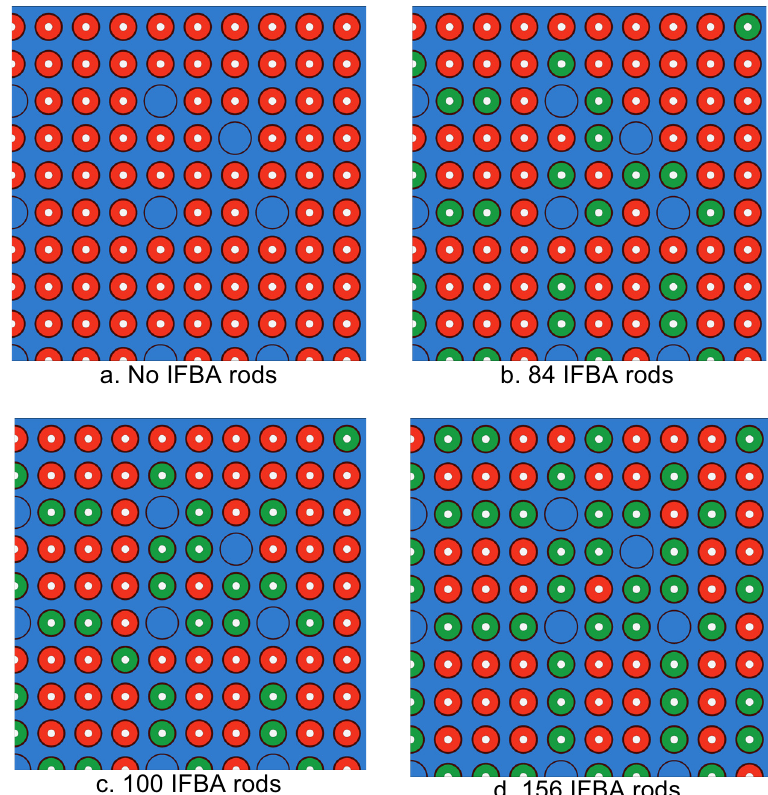
Fig. 3. I 2 S-LWR IFBA loading patterns – the top right quadrant of the assembly is shown; IFBA rods are indicated in